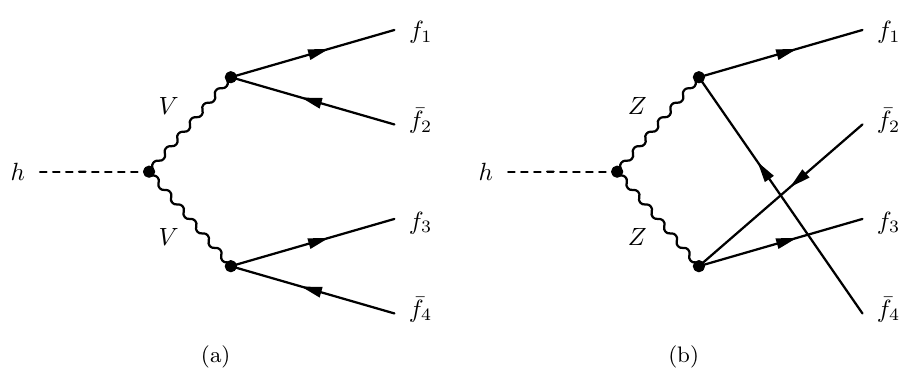
Figure 1 . Tree-level diagrams of the decay h 4 f with V = W ; Z. The diagram on the r.h.s. exists ! only if the fermion pairs are all quarks or all leptons of the same generation. The only couplings that change in the transition from the SM to the THDM are the hWW and hZZ couplings which involve an additional factor of sin ( (cid:12) (cid:11) (cid:0)